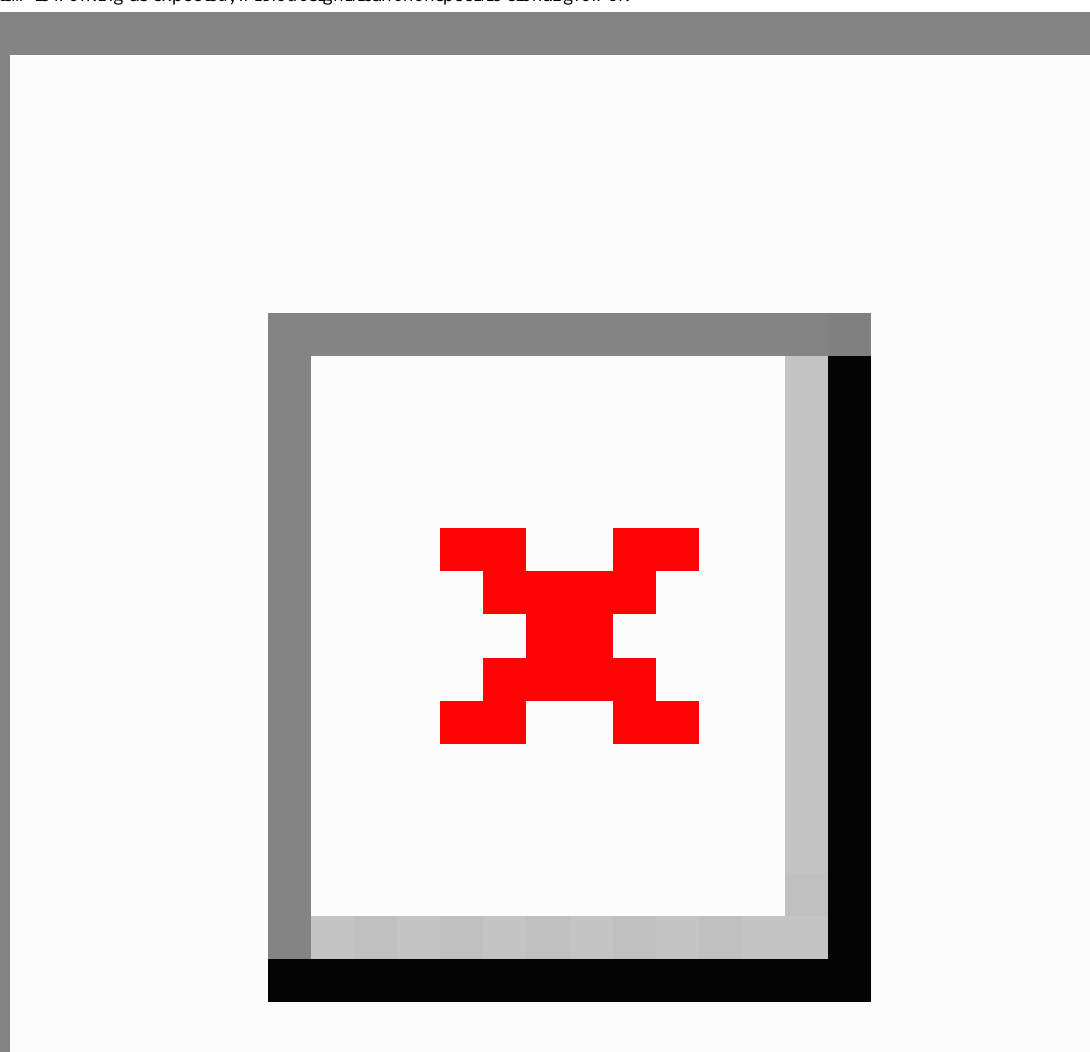
Figure 4. Adaptive mutation pilot experiment for cell growth treatment methodology. Lack of growth in small-scale pilot experiment demonstrates that system is working as expected, without significant nonspecific clonal